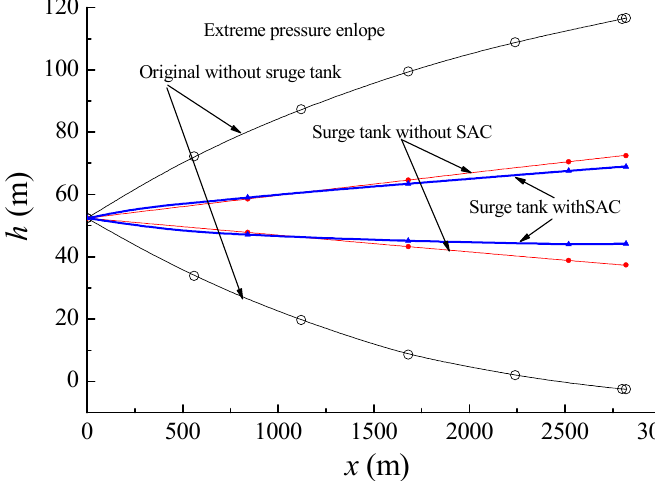
Figure 13. Comparison of the extreme pressure along the pipeline.